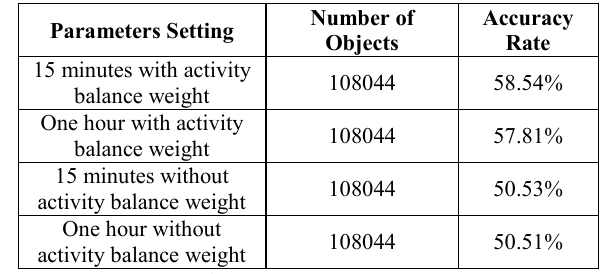
Table 1. The result of Experiment 1